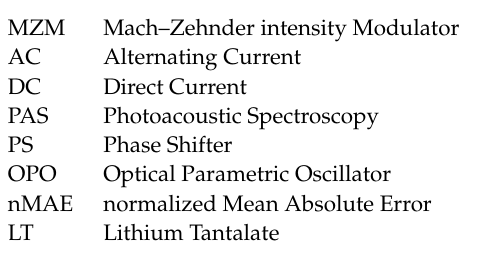
Figure 5; Source code S3: Python script mzm_validation.py to generate Figure 6; Data S4: